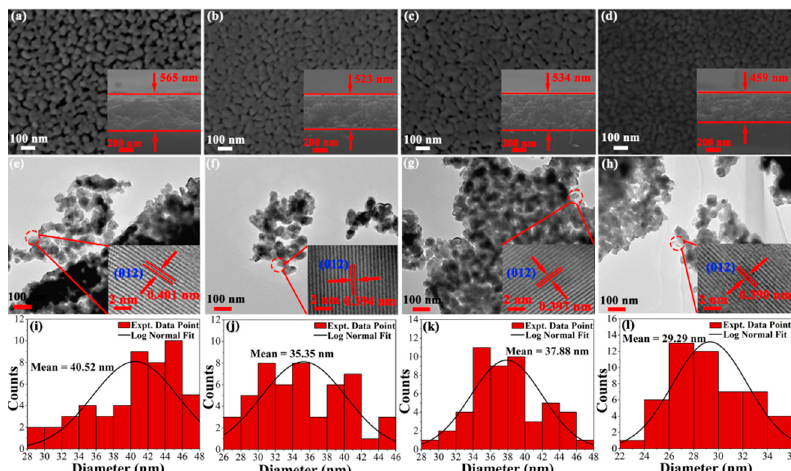
Figure 5. SEM images of surface morphologies for ( a ) BFO ( b ) BHFO ( c ) BFMO ( d ) BHFMO thin film and the insets in ( a – d ) show cross-sectionals of all thin films; ( e – h ) low magnification TEM images of BFO, BHFO, BFMO, BHFMO thin films and the insets in ( e – h ) show high resolution TEM images of all thin films; Histograms regarding particle size distributions of ( i ) BFO ( j ) BHFO ( k ) BFMO ( l ) BHFMO thin film, respectively.